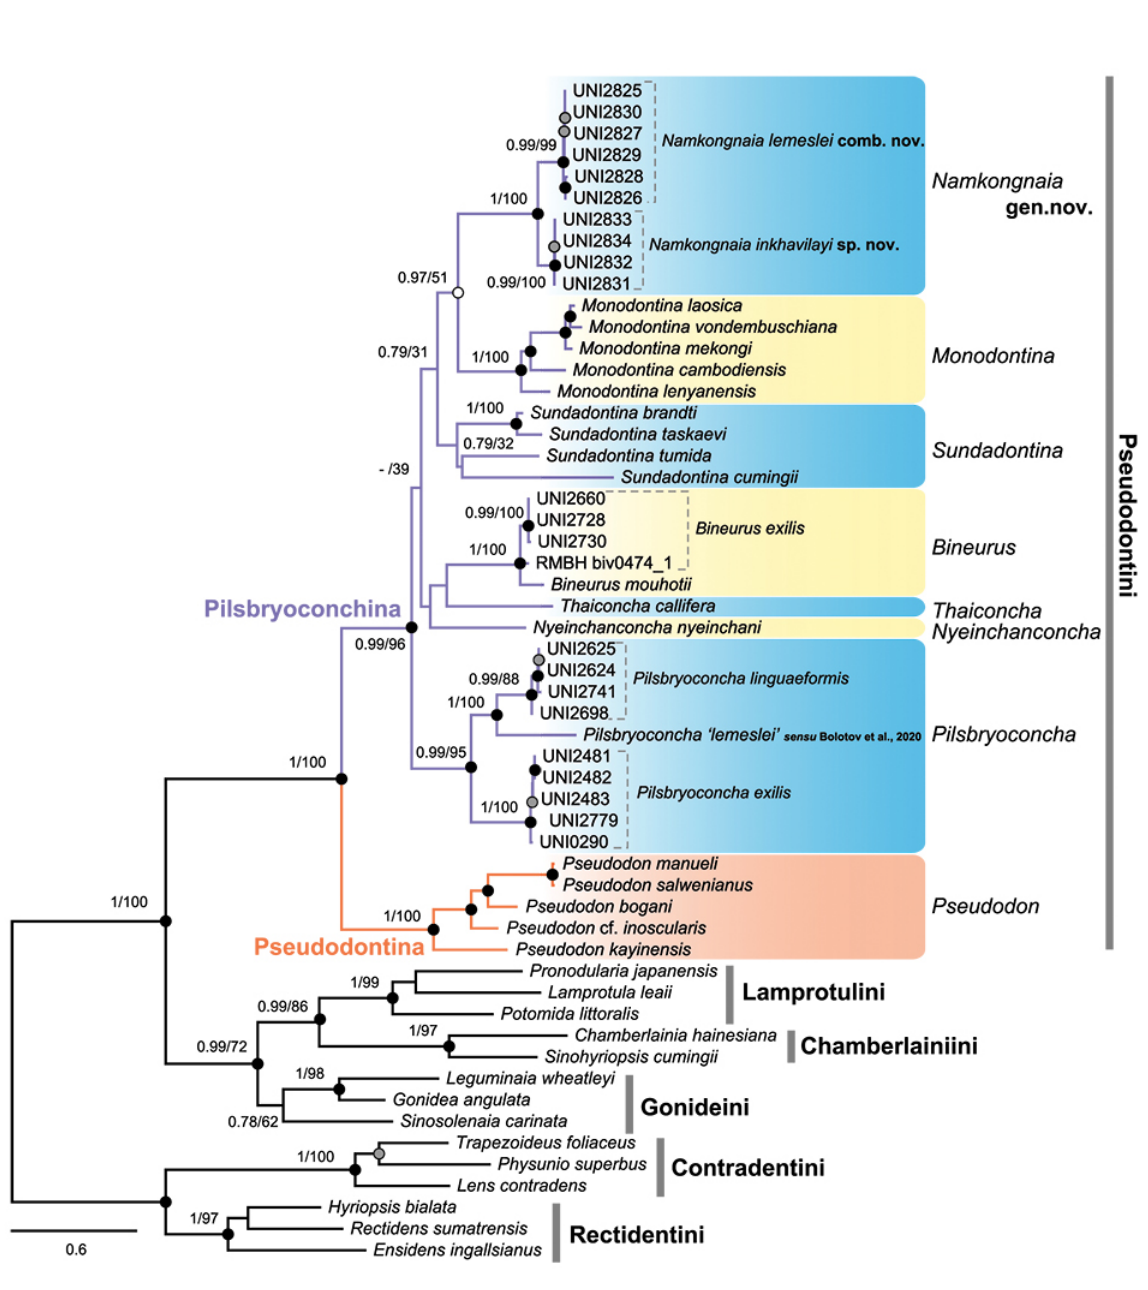
Fig. 1. Maximum likelihood (ML) tree of the subfamily Gonideinae based on the concatenated dataset of COI + 16S + 28S genes. Bootstrap values from ML and posterior probabilities from Bayesian inference analysis (BI) of the major nodes are listed as ML/BI. Nodes with posterior probabilities of BI ≥ 0.95 and ML bootstrap support values ≥ 70 were considered as sufficiently supported nodes (Huelsenbeck & Hillis 1993; Larget & Simon 1999), and are marked with black circles (supported by both BI and ML), white circles (supported only by BI), or grey circles (supported only by